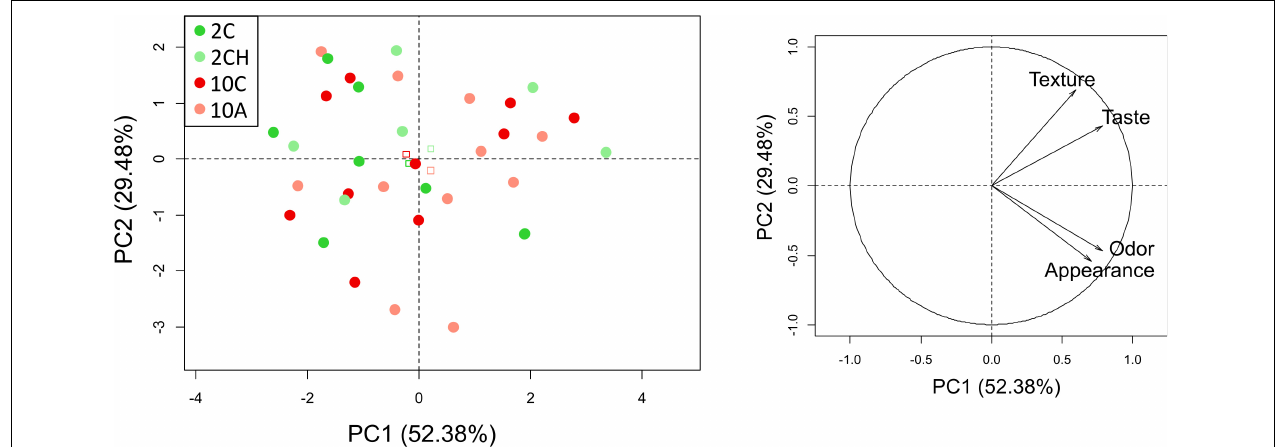
FIGURE 4 | Distribution of the samples organoleptic attributes on the basis of the first two principal components according to their treatment. Treatment symbols correspond to 2C: 2 ◦ C, pH 7.75, O 2 sat. 100% (dark green); 2CH: 2 ◦ C, pH 7.75, O 2 sat. 35% (light green); 10C: 10 ◦ C, pH 7.75, O 2 sat. 100% (dark red); 10A: 10 ◦ C, pH 7.4, O 2 sat. 100% (light red). Squares represent barycenters for each treatment. Then correlation circle on the right show the distribution of the explanatory variables in the space defined by the 2